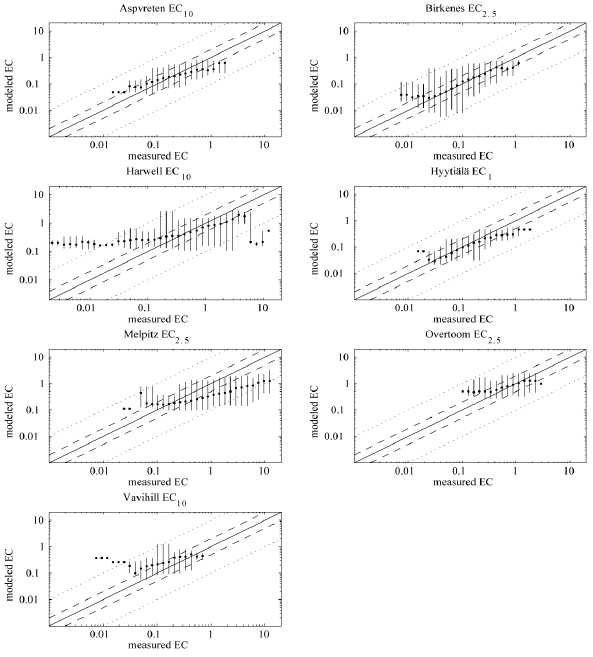
Fig. 4. Scatterplots of measured and modelled EC (standard model setup, STD) for seven European measurement stations, (a) Aspvreten EC 10 , (b) Birkenes EC 2.5 , (c) Harwell EC 10 , (d) Hyytiälä EC 1 , (e) Melpitz EC 2.5 , (f) Overtoom EC 2.5 , (g) Vavihill EC 10 . The measured EC are divided into logarithmically spaced concentration bins. Each order of magnitude is divided into 10 bins. The points represent the median of the model results for each concentration bin of measured EC. The vertical lines show the range of model results for each bin. Solid lines represent 1:1 lines. Dashed lines represent 2:1 and 1:2 lines and dotted lines represent 10:1 and 1:10 lines. Unit: µg m -3 .